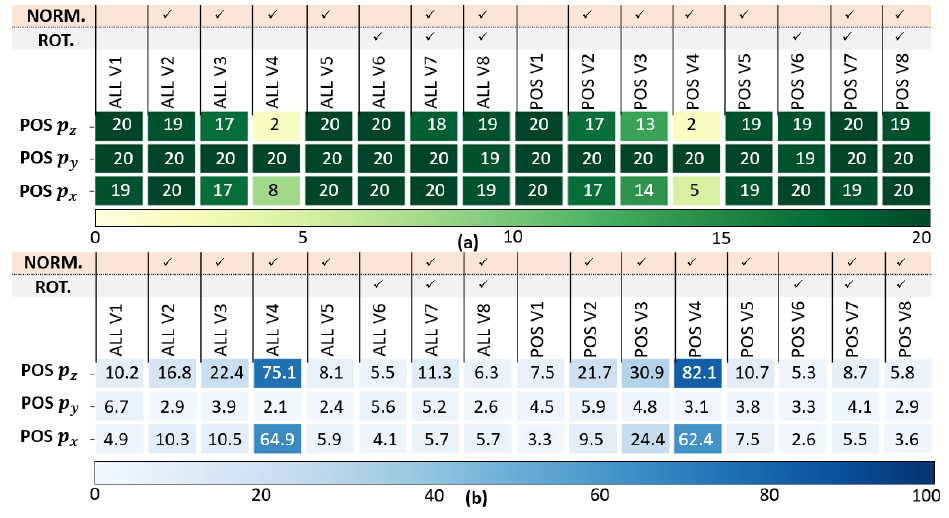
Figure 6. Position analysis: ( a ) Success Rate C 1 , ( b ) Error Rate C 2 (in %) of LSTM ALL , V LSTM POS , V 1 − V 8